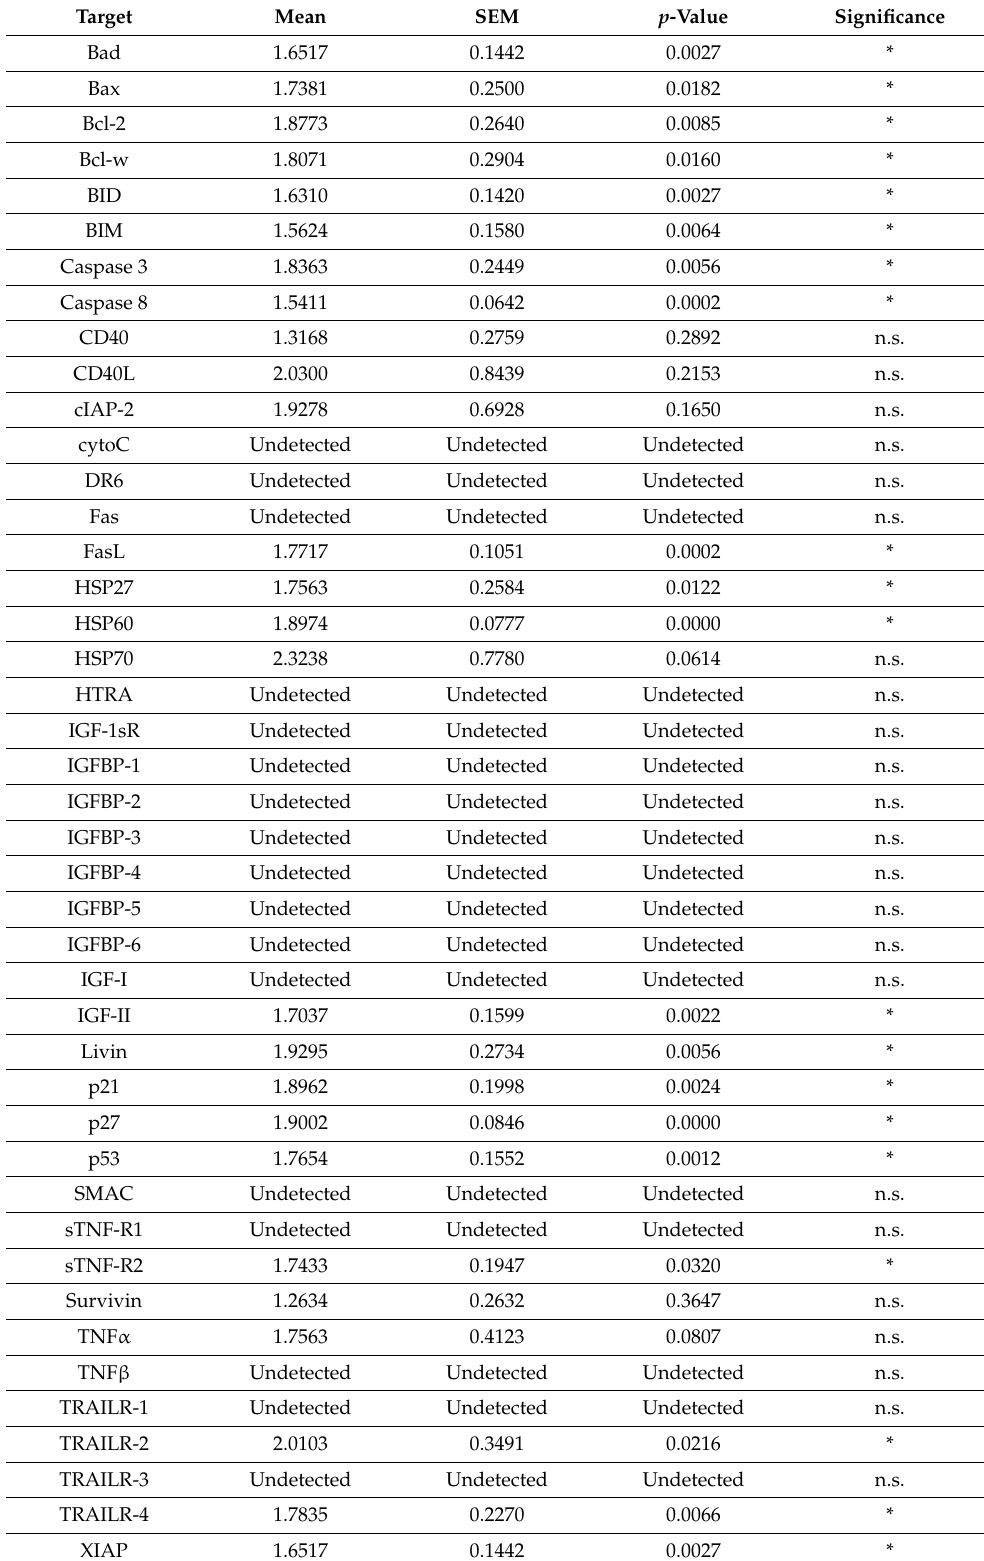
Table 1. Apoptosis antibody array results. Mean fold change of MYH7 WT/E848G-EGFP relative to MYH7 WT/WT-EGFP , n = 3 biological and n = 2 technical replicates per target. * indicates p < 0.05 significance calculated with Student’s t